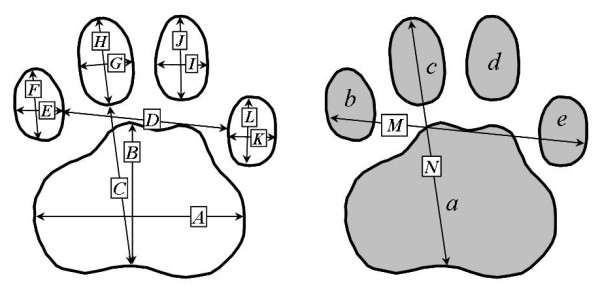
14 linear and 5 area measurements of the tracks. A = heel pad width, B = heel pad length, C = heel to second toe length, D = outer toe spread length, E = inner toe width, F = inner toe length, G = second toe width, H = second toe length, I = third toe width, J = third toe length, K = outer toe width, L = outer toe length, M = total width, N = total length, a = area of heel pad, b = area of inner toe, c = area of second toe, d = area of third toe, e = area of outer toe.